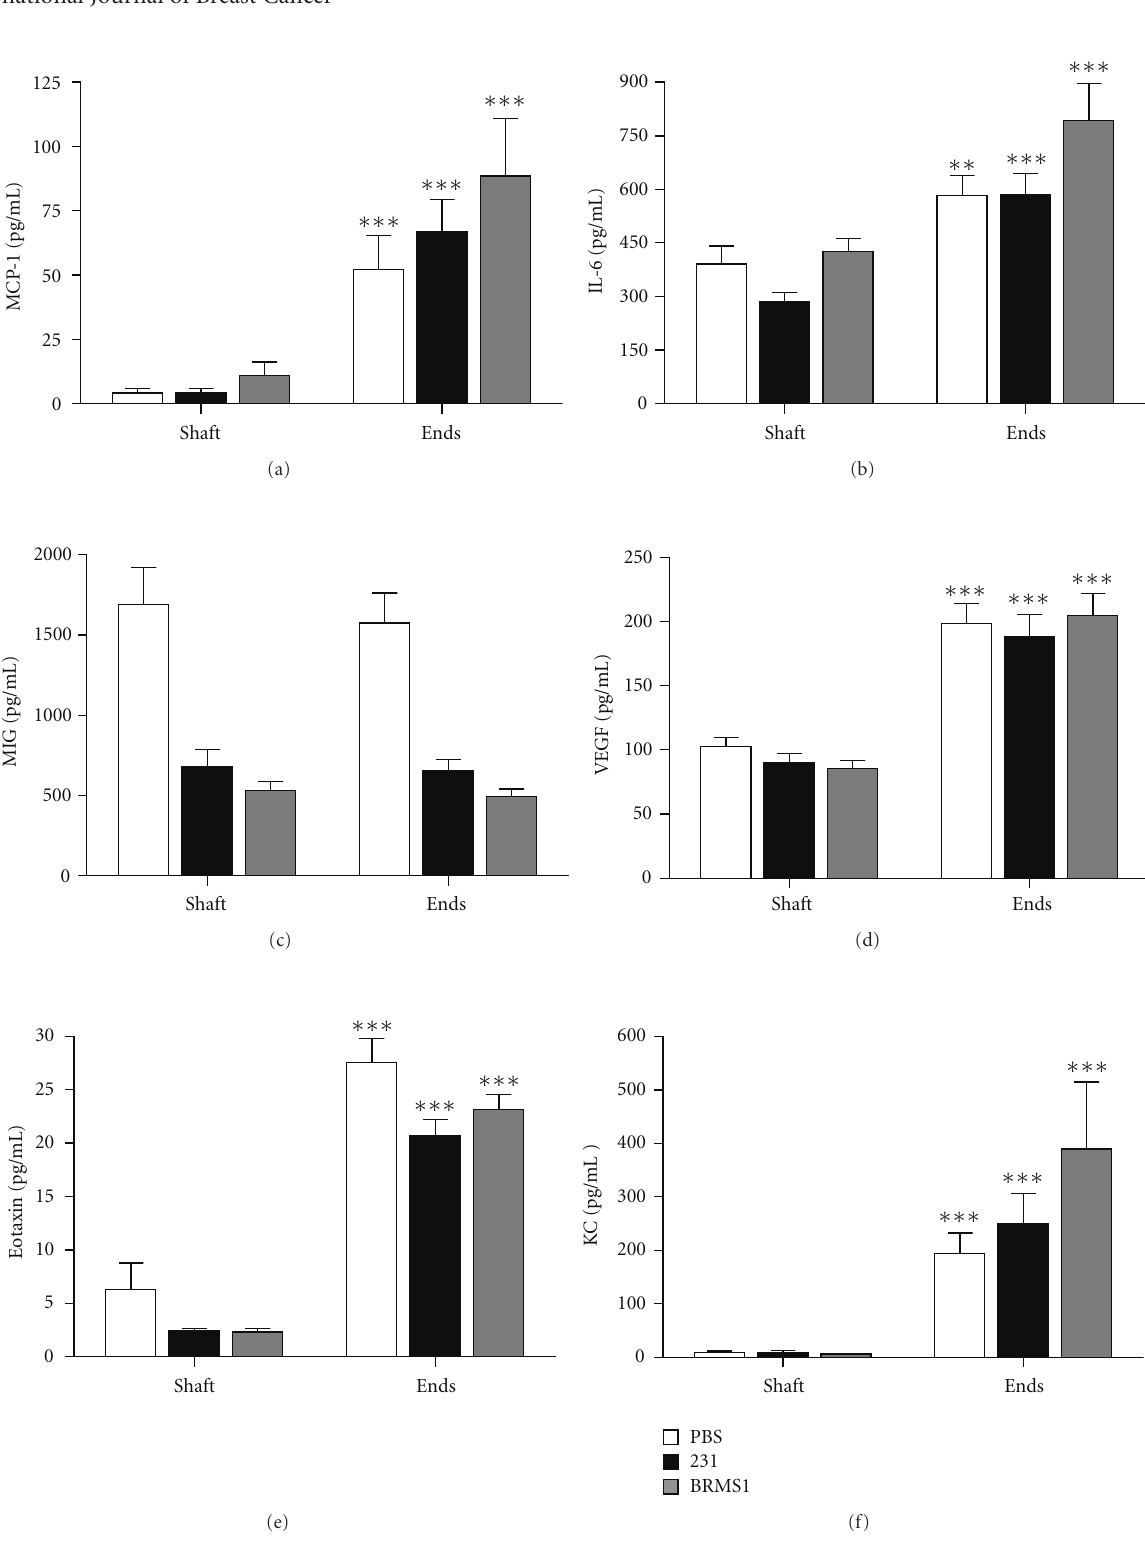
Figure 2: Cytokine levels in bone diaphysis versus bone epiphysis. Athymic nude mice received intracardiac inoculations of either PBS, MDA-MB-231 GFP , or MDA-MB-231BRMS1 GFP cells. Femurs were harvested at days 3, 11, 19, and 27 after inoculation and separated into shafts and ends. Shown here are the results from day 19, but the results were similar for the other days. Bone sections were crushed and cultured in serum-free medium for 24 hours. Resulting supernatants were assayed for MCP-1 (a), IL-6 (b), MIG (c), VEGF (d), eotaxin (e) and KC (f). MIP-2 values were very small or below the level of detection and were not included. With the exception of MIG, the cytokine levels were significantly higher in the ends of the femur than in the shaft. ∗∗∗ P < 0 . 001; ∗∗ P = 0 . 01–0 . 001. n = 8 for each